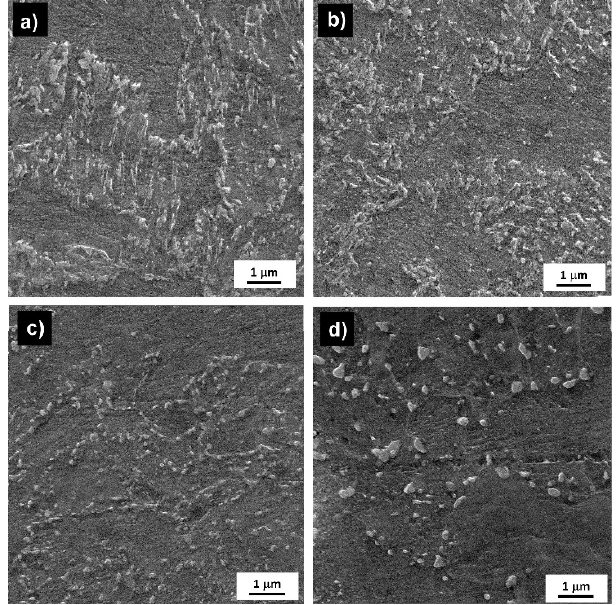
Figure 4. Microstructure of DP980 steel upon slow heating followed by rapid cooling at peak temperatures of: ( a ) 400 ◦ C, ( b ) 500 ◦ C, ( c ) 600 ◦ C, and ( d ) 700 ◦ C. ( α = ferrite, α ´ R = tempered martensite).